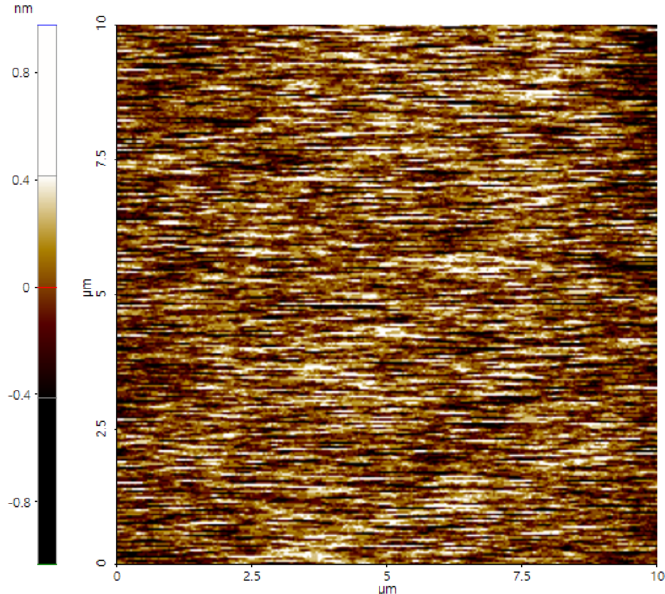
Figure 2. AFM images of the n-InGaAs cap layer for the scan area of 10 µm × 10 µm.